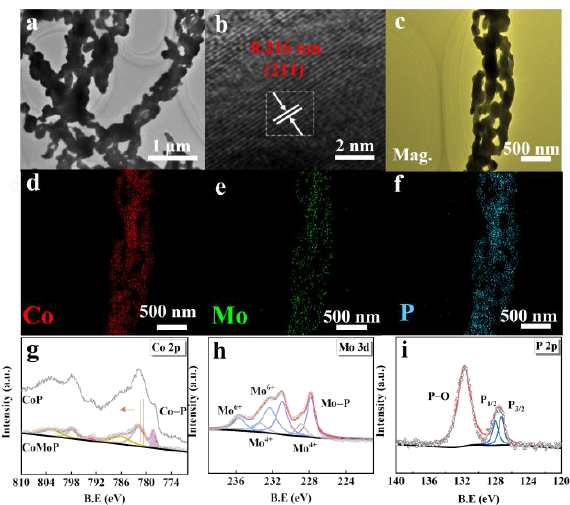
Figure 2. XRD patterns of CoMoO 4 , CoMoP, and CoP NFs.